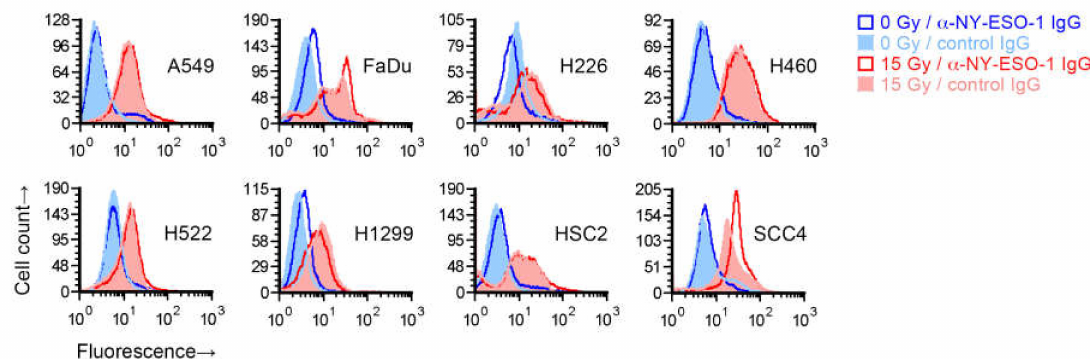
Figure 2. E ff ect of radiation on cell surface NY-ESO-1 measurement by fluorescence flow cytometry. Sub-confluent adherent cultures of indicated cell lines that had been grown in parallel to same cell density were treated with 0 or 15 Gy X-rays. After four days, adherent cells were collected by scraping and examined by flow cytometry for binding of an unconjugated mouse IgG1 antibody against NY-ESO-1. Antibody binding was indirectly detected with a fluorophore-conjugated rat antibody against mouse IgG. Binding of a control IgG1 (normal mouse serum fraction) was similarly detected. Shown are representative histograms of viable cells identified by 7 -amino-actinomycin D